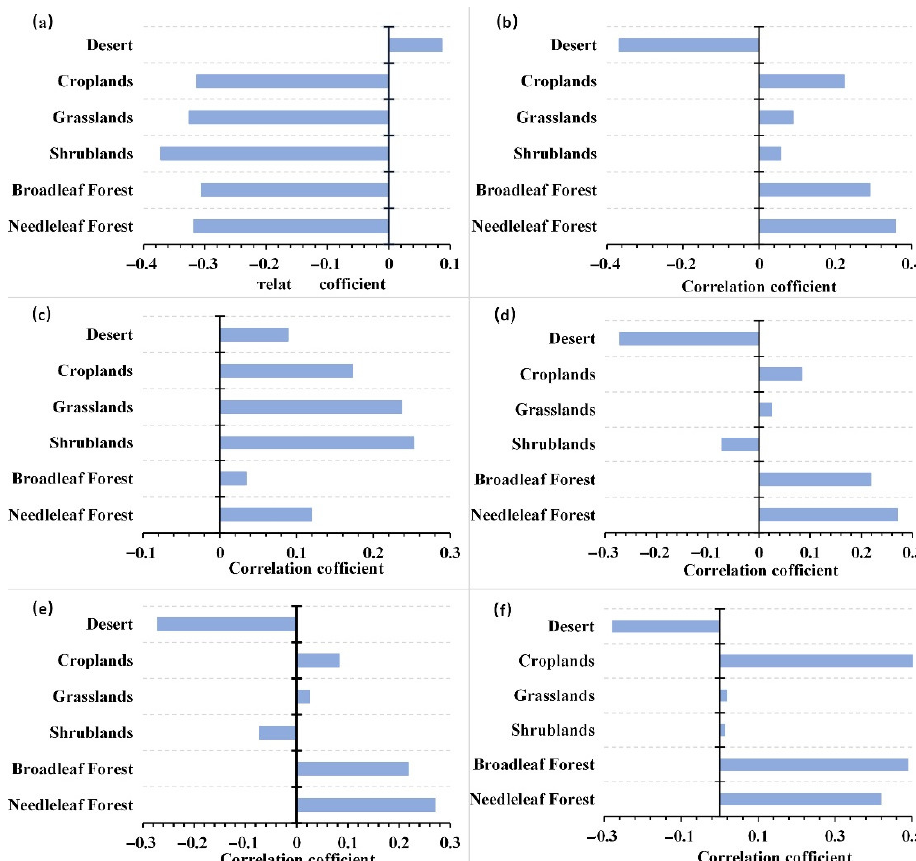
Figure 10. Spatial correlation between the NDVI of different vegetation types and climate extremes indices in China over the 1998–2018 period: ( a ) DTR (°C); ( b ) Rx5day (mm); ( c ) Rx1day (mm); ( d ) indices in China over the 1998–2018 period: ( a ) DTR ( ◦ C); ( b ) Rx5day (mm); ( c ) Rx1day (mm); ( d ) TXn TXn (°C); ( e ) TNn (°C); ( f ) TXx (°C). ( ◦ C); ( e ) TNn ( ◦ C); ( f ) TXx ( ◦